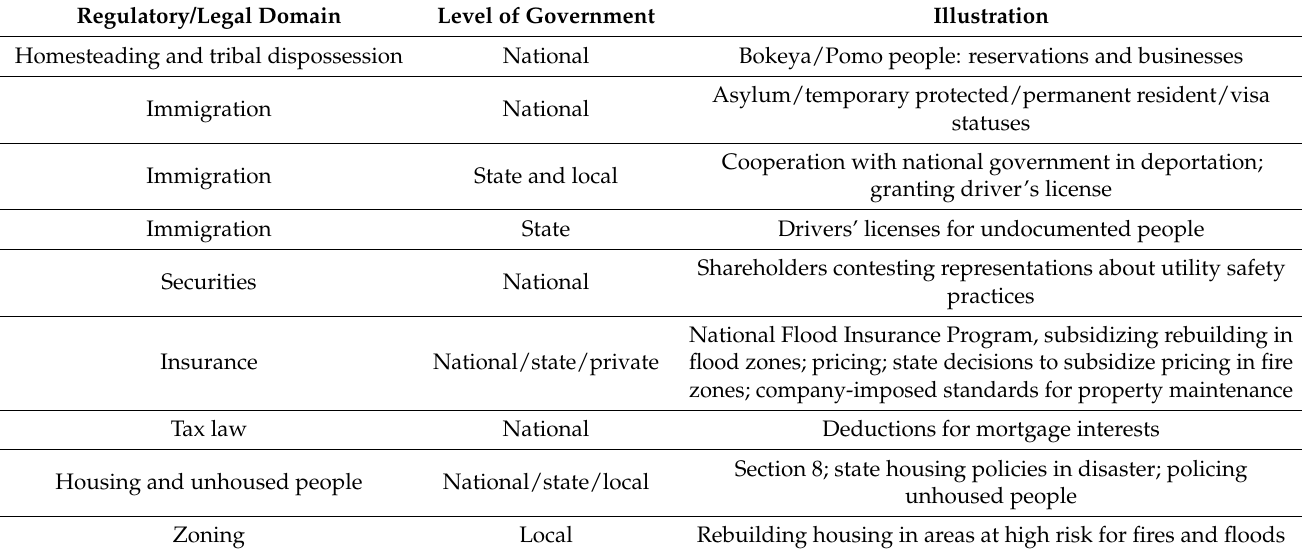
Table 2. Legal and Regulatory Structures in